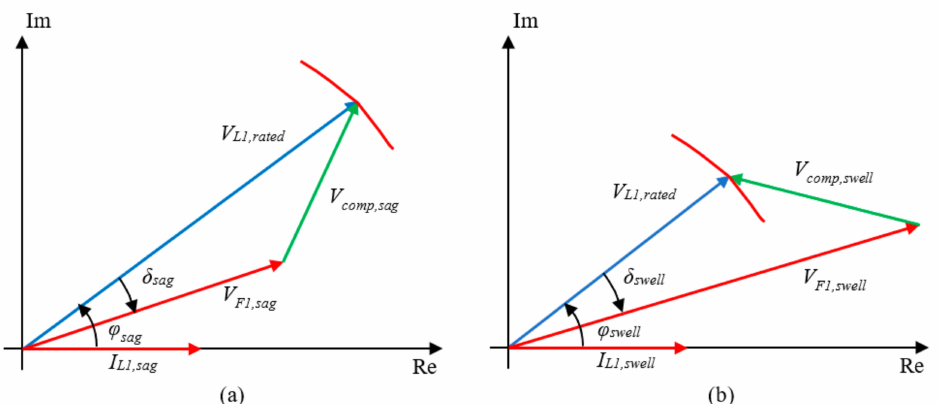
Figure 3. Phasor diagram of feeder 1 voltage, the load 1 voltage, and compensation voltage. ( a ) Voltage sag and ( b ) → → → → → V L 1, rated , V F 1, sag , V comp , sag , V F 1, swell and V comp , swell are the voltage vectors of load voltage 1, feeder 1 voltage swell. Where, voltage (with sag), sag compensation voltage injected, feeder 1 voltage (with swell) and swell compensation voltage injected. → → I L 1, sag and I L 1, swell are the vectors of the load currents in the presence of sag and swell respectively. δ sag and ϕ sag are the → → → V L 1, rated and the vectors V F 1, sag and I L 1, sag respectively. In the same way, δ swell and ϕ swell are angles between the vector → → → V L 1, rated and the vectors V F 1, swell and I L 1, swell the angles between the vector